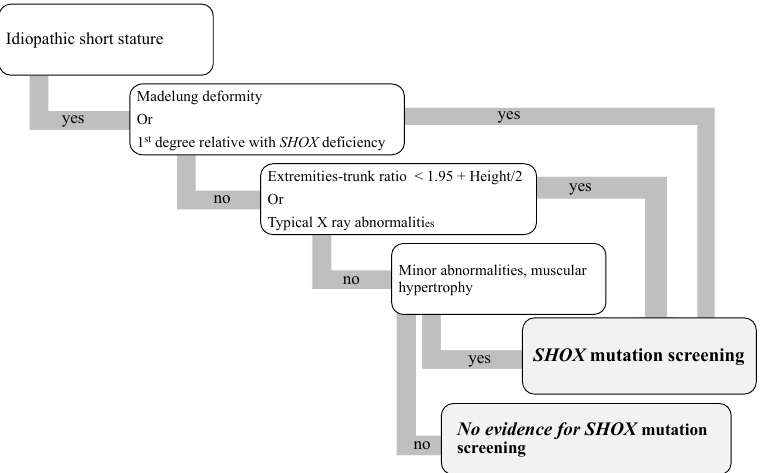
Figure 7. Diagnostic algorithm for SHOX mutation screening (adapted from Vanelli 2020, Binder 2011, 2018 and Fukami 2016).